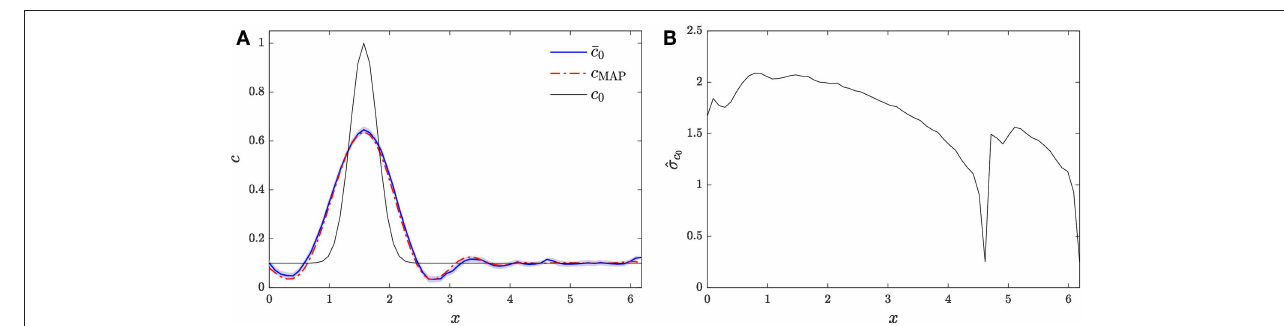
A 1 . (A) Posterior mean c 0 compared against MAP estimate c MAP and the actual release profile c 0 . ¯ =